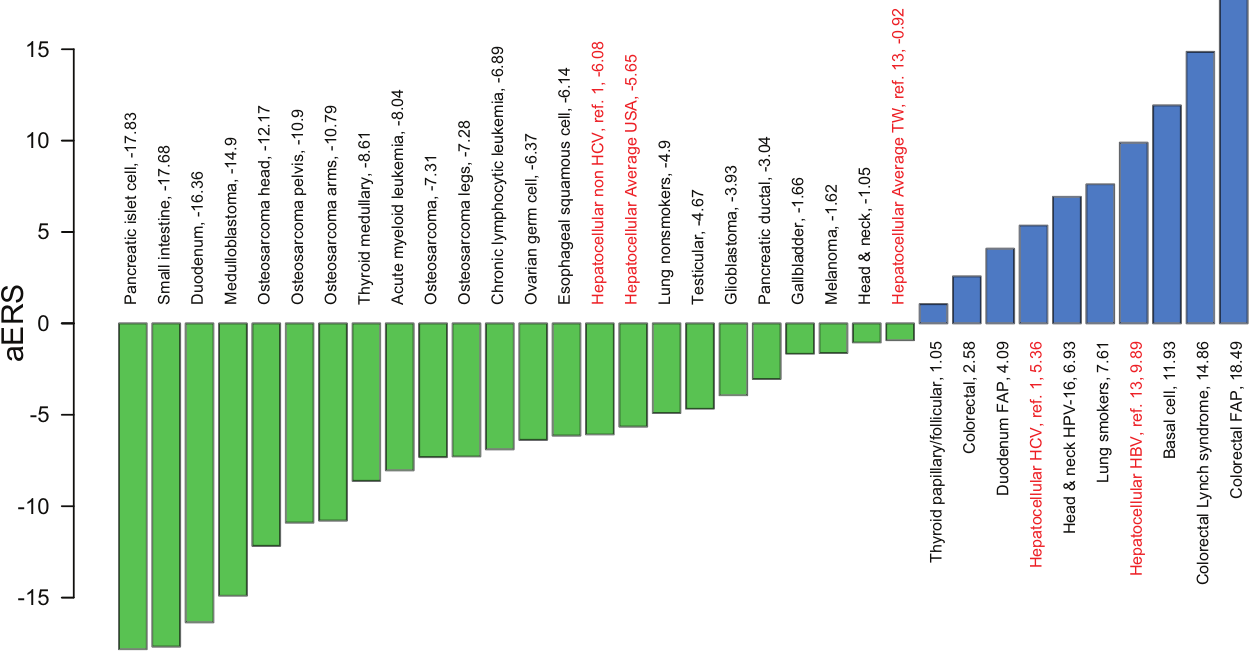
Figure 1. Effect of risk stratification of hepatocellular carcinoma incidence. This figure is an enhanced version of Figure 2 in ref. 1 showing the adjusted ERS (aERS=ERS + 18.49) for human cancers. ‘Hepatocellular Average USA’ and ‘Hepatocellular Average TW’ denotes the entire population of HCC patients, including both HCV and non HCV cases, in the USA and in Taiwan, respectively. Incidence was taken from the SEER database. ‘Hepatocellular HBV’ denotes HCC patients who are also HBV carriers. HCC lifetime risk for HBsAg-positive patients was taken from ref.